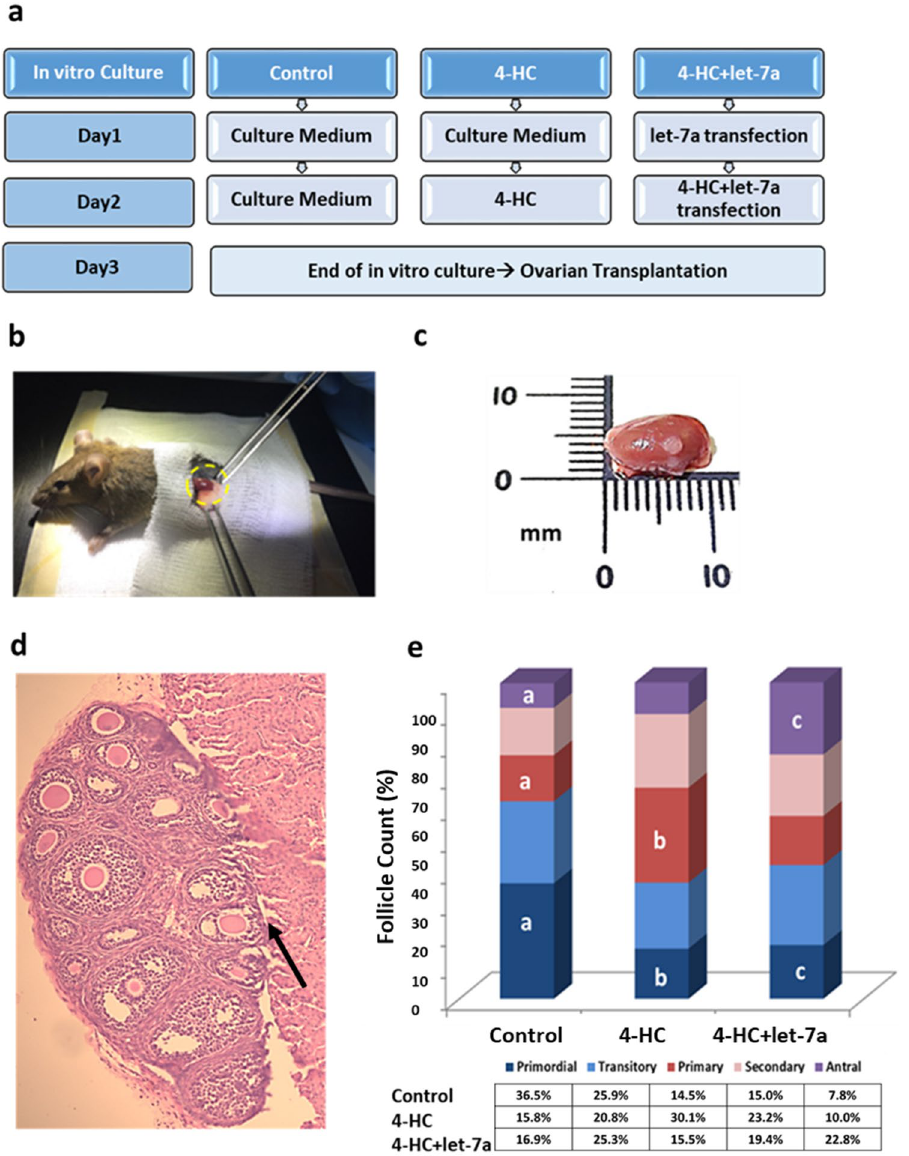
Figure 3. ( a ) Postnatal-day 3 (PND3) ovaries were cultured for 2 days under three different conditions: control, 4-HC, and 4-HC + let-7a. ( b ) Ovarian transplantation procedure in the kidney capsule of adult female mice. ( c ) Kidney collected at day 21 post-transplantation. ( d ) Arrow shows the PND3 ovaries. Hematoxylin & Eosin (H&E) staining on a section of grafted ovary, showing the fusion between the two organs. Follicles from different developmental stages were identified. ( e ) Percentage of follicles in different developmental stages (primordial; blue, transitory; light blue, primary; red, secondary; pink, antral; purple) in 3 groups (control, 4-HC, 4-HC + let-7a) in the transplanted ovaries (N = 3/condition). The error bars represent the standard error, the differences between the letters a-b, a-c for each type of follicle are statistically significant p <